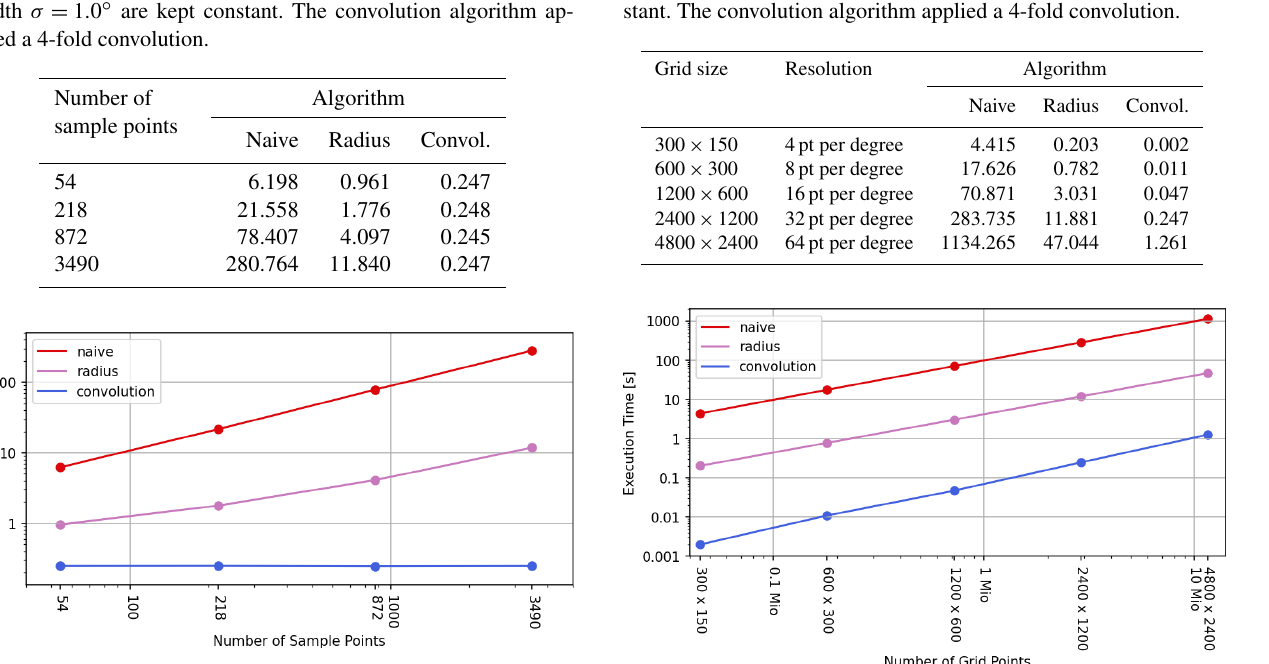
Figure 5. Plot of execution times from Table 2 against number of grid points. Both axes use a logarithmic